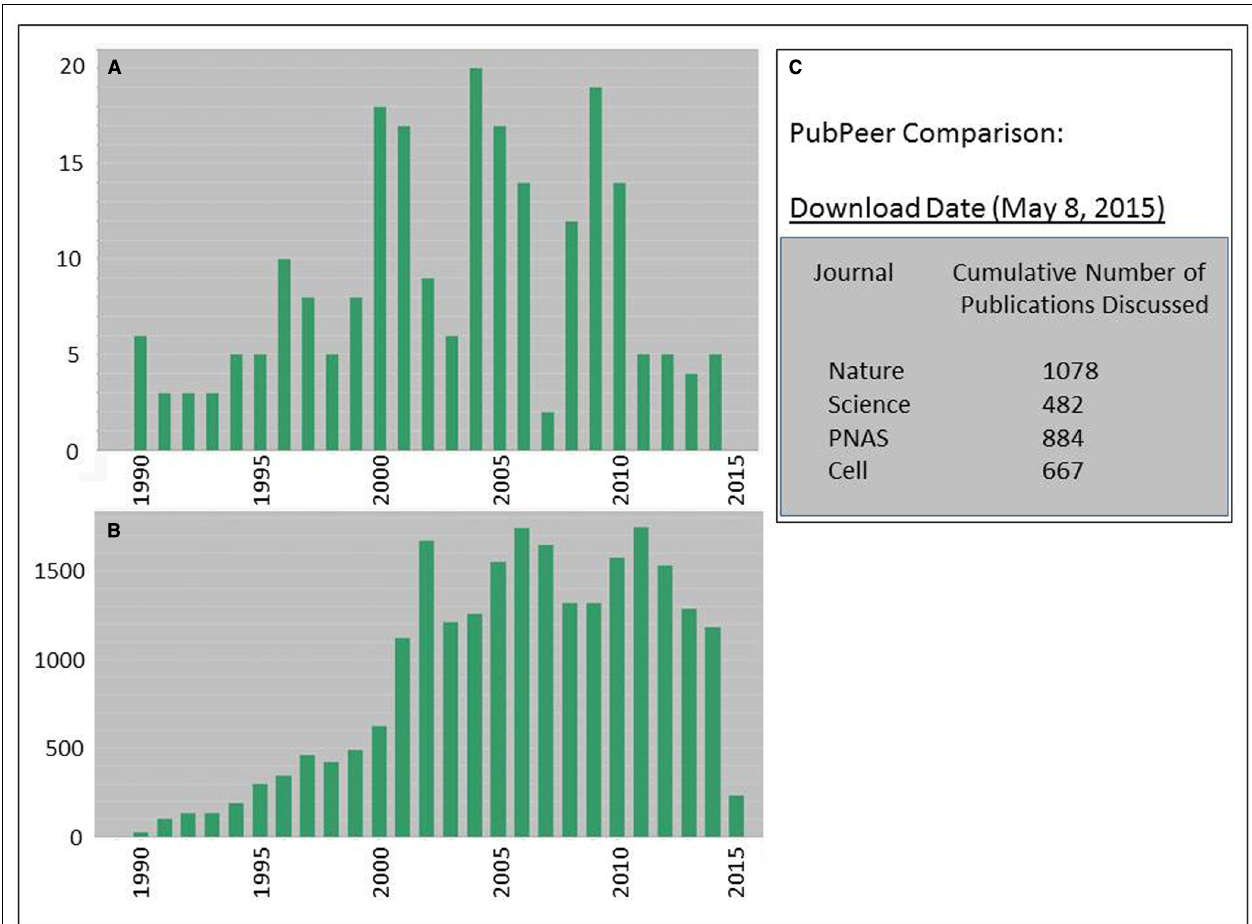
FIGURE 2 | Tracking the impact of questionable research through retraction notices (A,B) and post-peer review (C). (A) A data search of Thompson-Reuters Web-of-Science (WOS) using the following Search Criteria: PUBLICATION NAME: (Science or Nature or Cell or Proceedings of the National Academy of Sciences of the United States of America) AND YEAR PUBLISHED: (1990–2015) Refined by: DATABASES: (WOS) AND DOCUMENT TYPES: